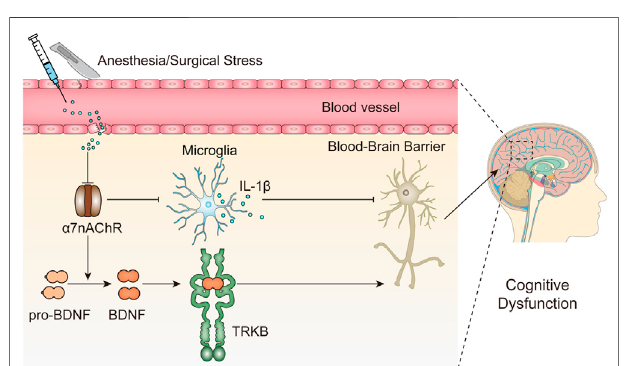
FIGURE 6 | Working hypothesis of the role α 7nAChR-mediated neuroprotection in PNDs. Surgery and anesthesia lead to a wide range of in fl ammatory cytokines in the serum, such as IL-1 β , and disrupts the blood- brain barrier integrity, which may facilitate the downregulation of α 7nAChR in the brain, in particular, but not restricted to the hippocampus. Subsequently, the inhibition of α 7nAChR triggers a cascade of downstream signaling events including proin fl ammatory responses (IL-1 β ) and BDNF decrease and may further cause neuronal apoptosis, consequently contributing to cognitive